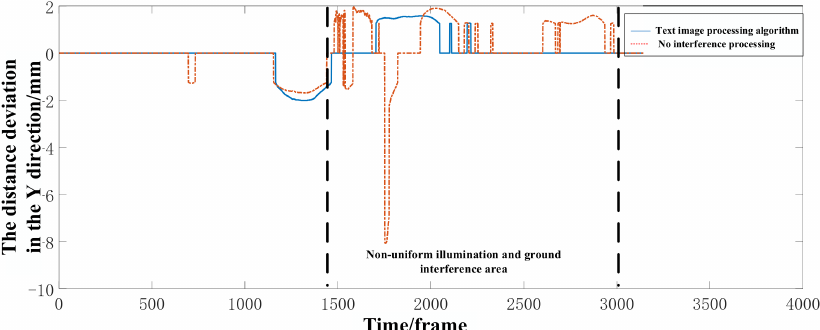
Figure 15. Comparison of real vehicle operation effect with and without anti-interference